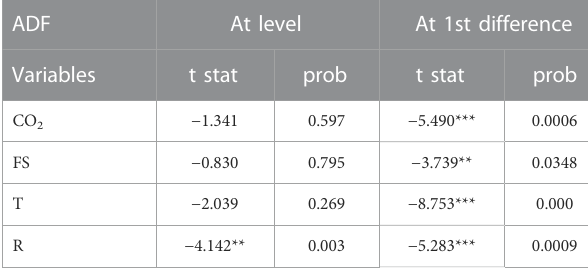
TABLE 2 Augmented dicky fuller test.